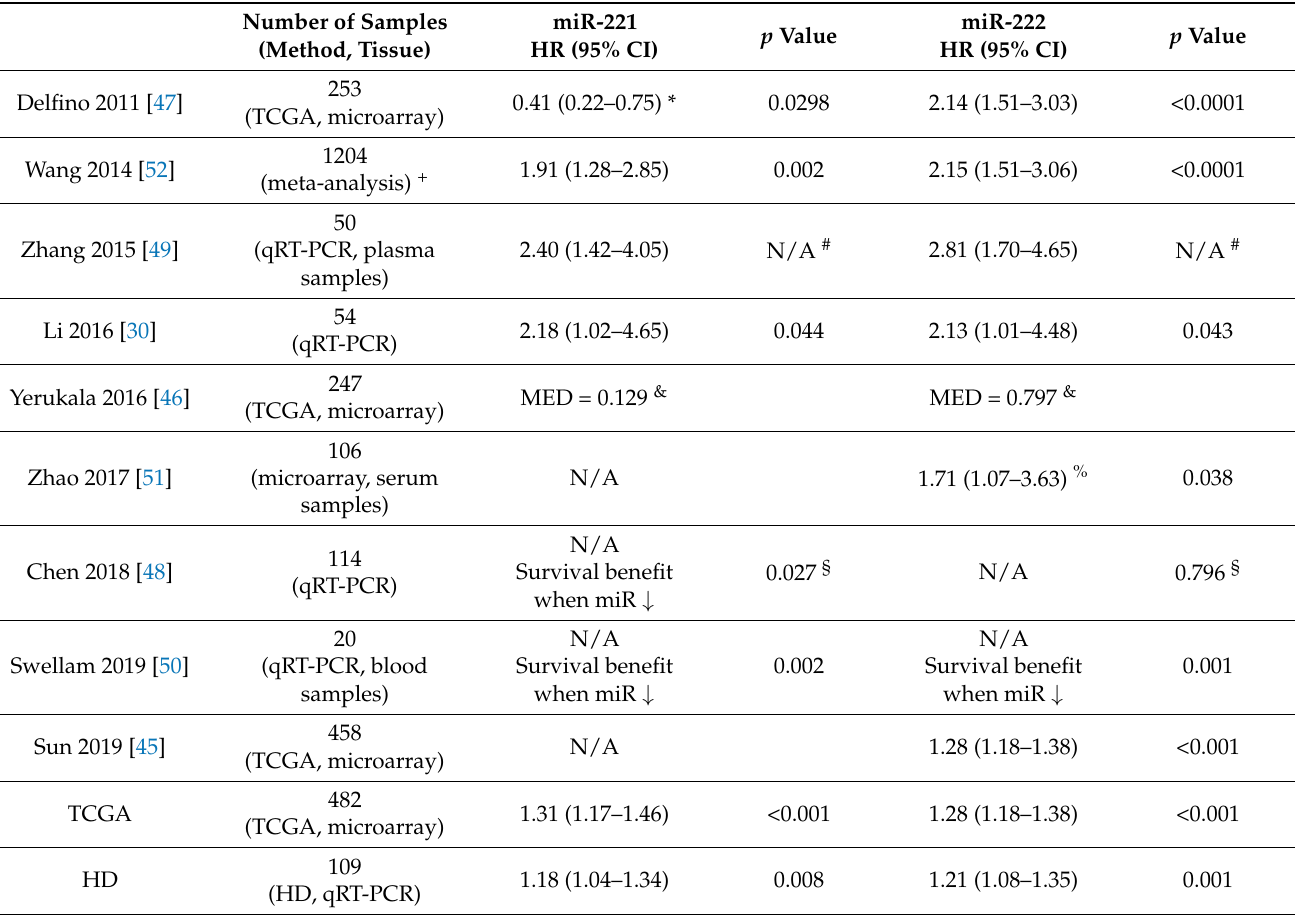
Table 3. Summary of previously published data on the correlation between miR-221/222 expression and survival of GBM